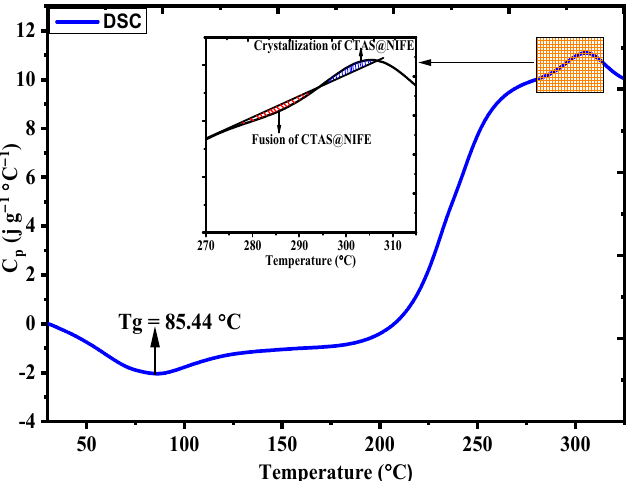
Figure 2. Differential scanning calorimetry plot for chitosan-ascorbic acid@NiFe 2 O 4 (inset showing the fusion and crystallization process) within the temperature range of 50–350 °C.